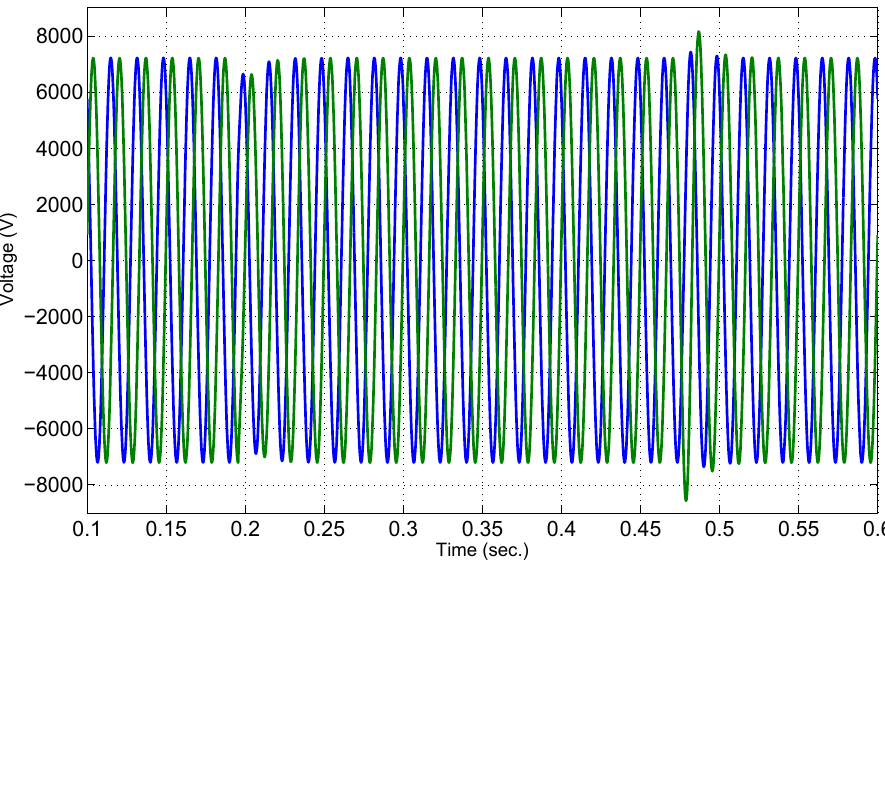
Figure 16. The phase a and b voltages of the load generated by the Matlab/